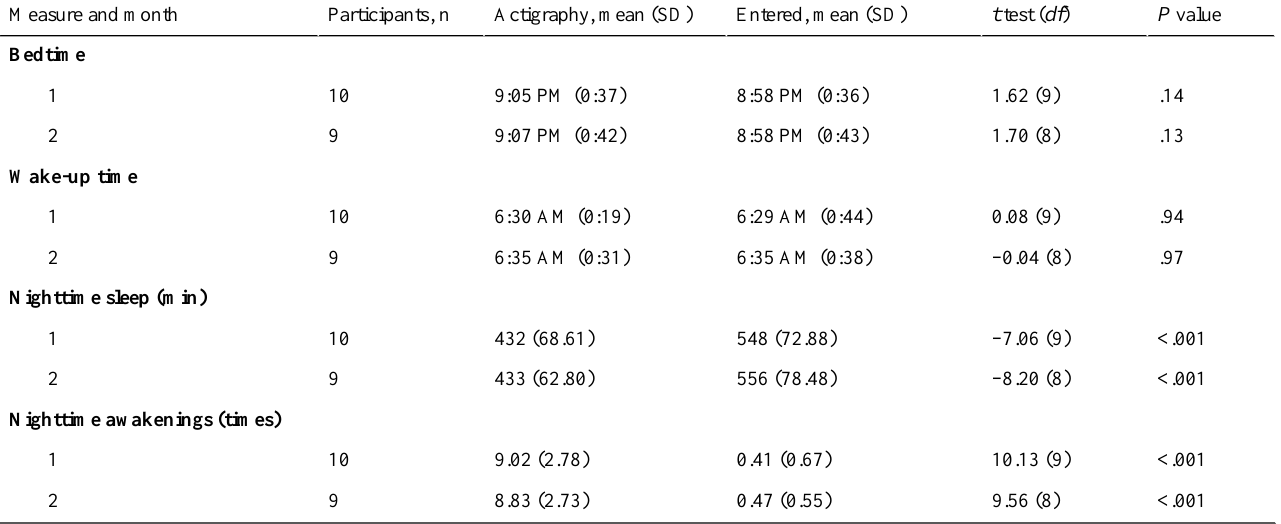
Table 1. Children’s sleep habits according to actigraphy and entered data by